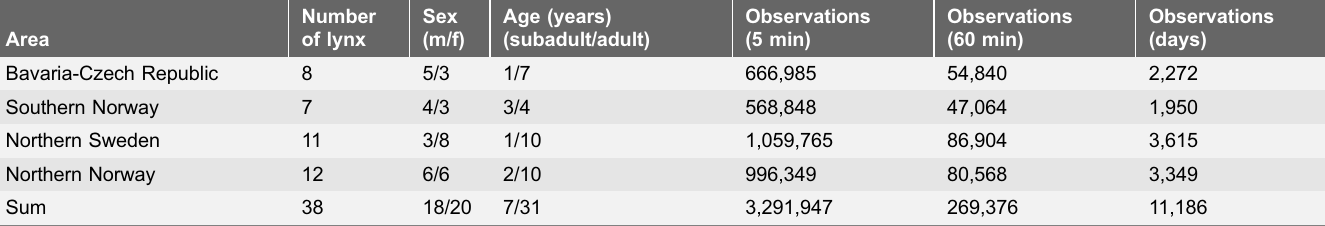
Table 1. Distribution of studied lynx according to study site and status and description of the available data. Area